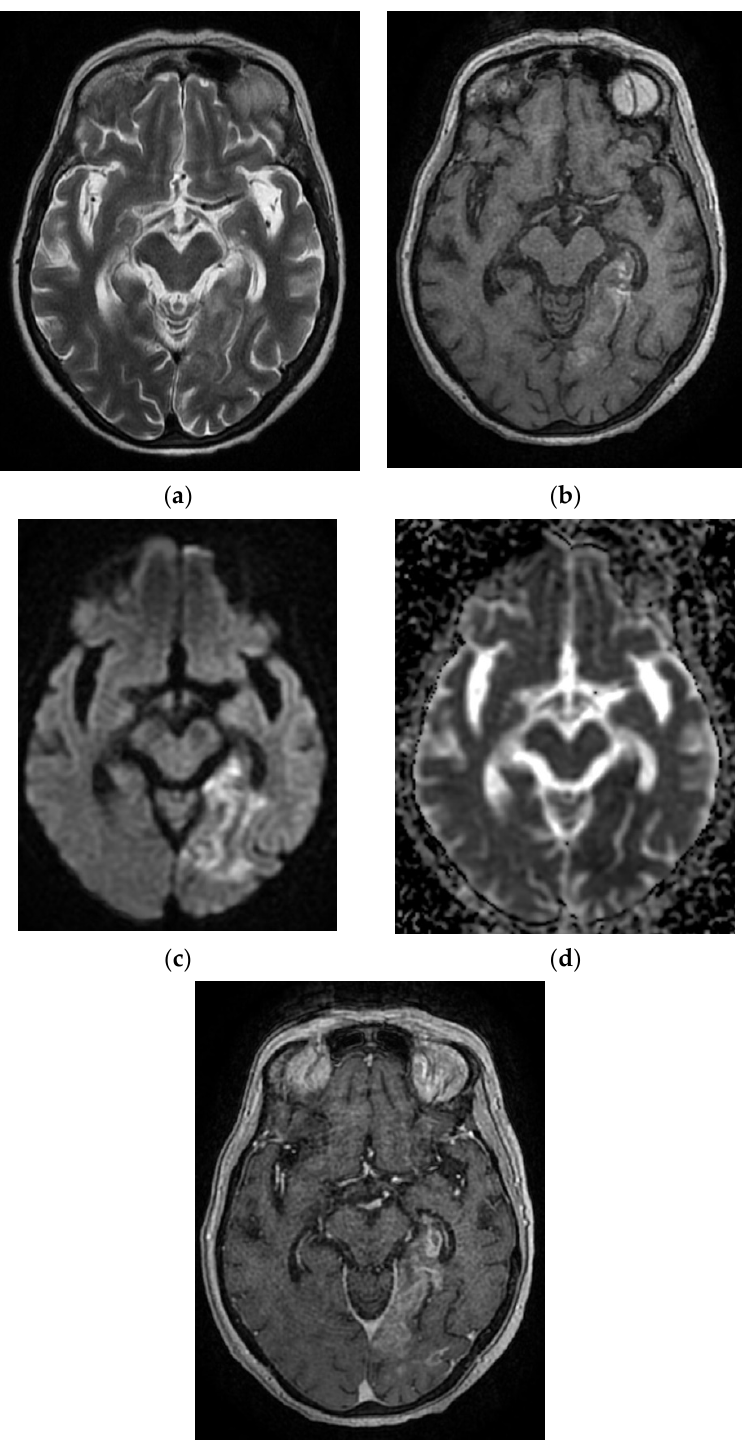
Figure 14. After 11 days from the first pulmonary CT, the cranio-cerebral MRI in the Case 10 patient showed foreshadowing of intense T2 signal ( a ), with deposits of predominantly peripheral methemoglobin ( b ), deficient restriction of diffusion ( c , d ) and gyriform gadolinium I ( e ), developed in the cortical–subcortical–occipital left median side with extension in the thalamic nucleus on the same part. In conclusion, infarction hemorrhagically transformed into superficial and profound territories of the left posterior cerebral artery.